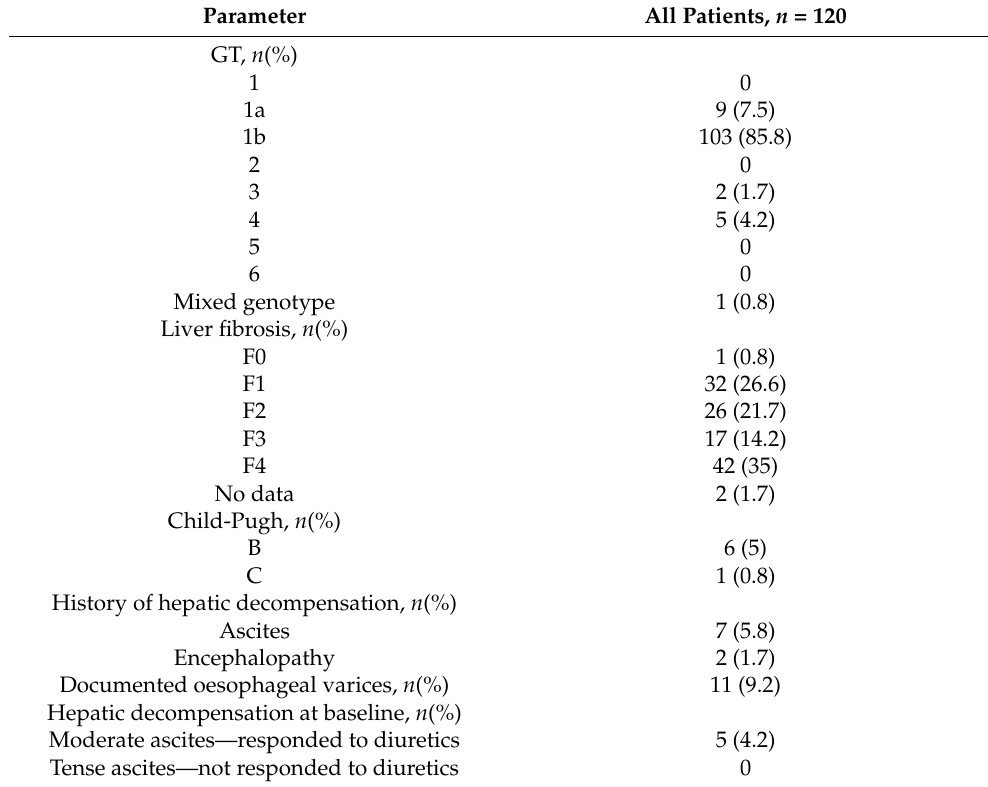
Table 3. Characteristics of liver